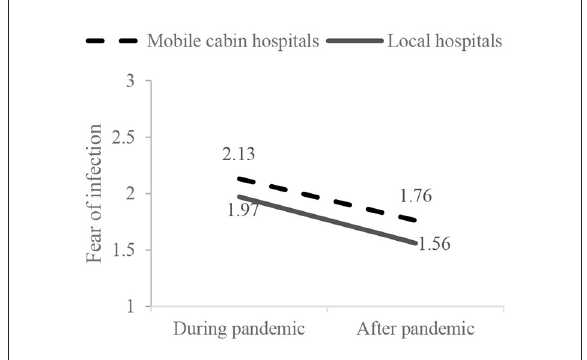
FIGURE3 Interactive effects on the medical staff’s fear of infection.